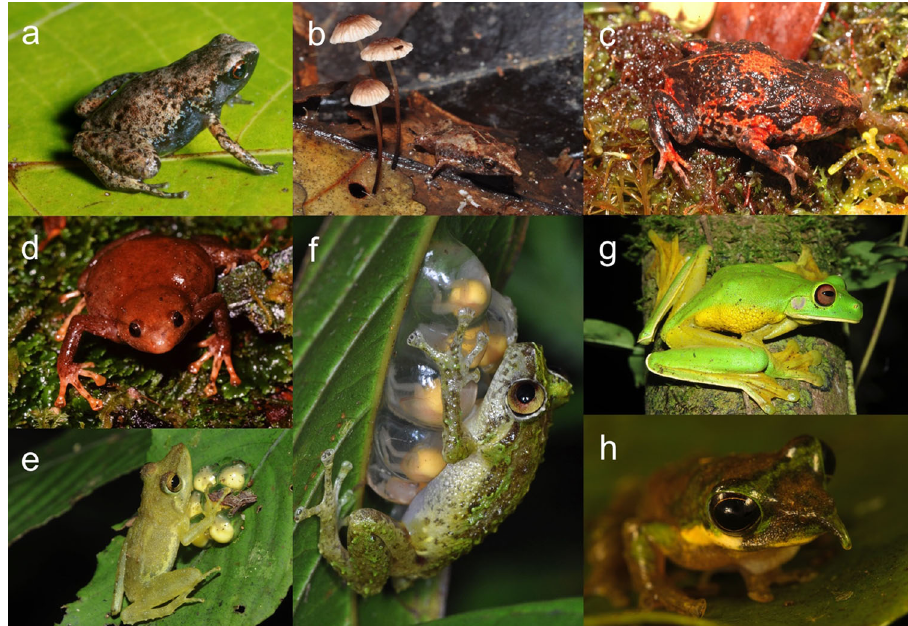
Fig. 2 Melanesian frog species described within the last 15 years illustrating the ecological and morphological diversity of the fauna. a Paedophryne titan and b Choerophryne gracilirostris – examples of lineages that have undergone convergent minaturisation; c Choerophryne alpestris – a fossorial species within a largely scansorial lineage; d Xenorhina macrodisca – scansorial species within a largely fossorial lineage; e Cornufer custos and f Oreophryne oviprotector - independent derivations of complex parental care; g Litoria pallidofemora – extensive digital webbing for parachuting; and h Litoria pinocchio – sexually dimorphic and erectile rostral spikes. Photographs F. Kraus ( a ), S. Richards ( b – g ), and courtesy of T. Laman ( h